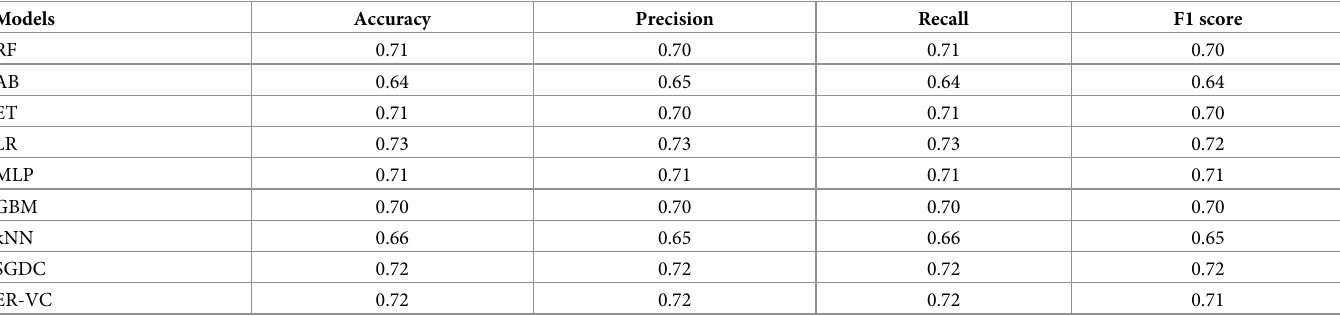
Table 3. Classification results of machine learning models using TF-IDF on imbalanced dataset. Models